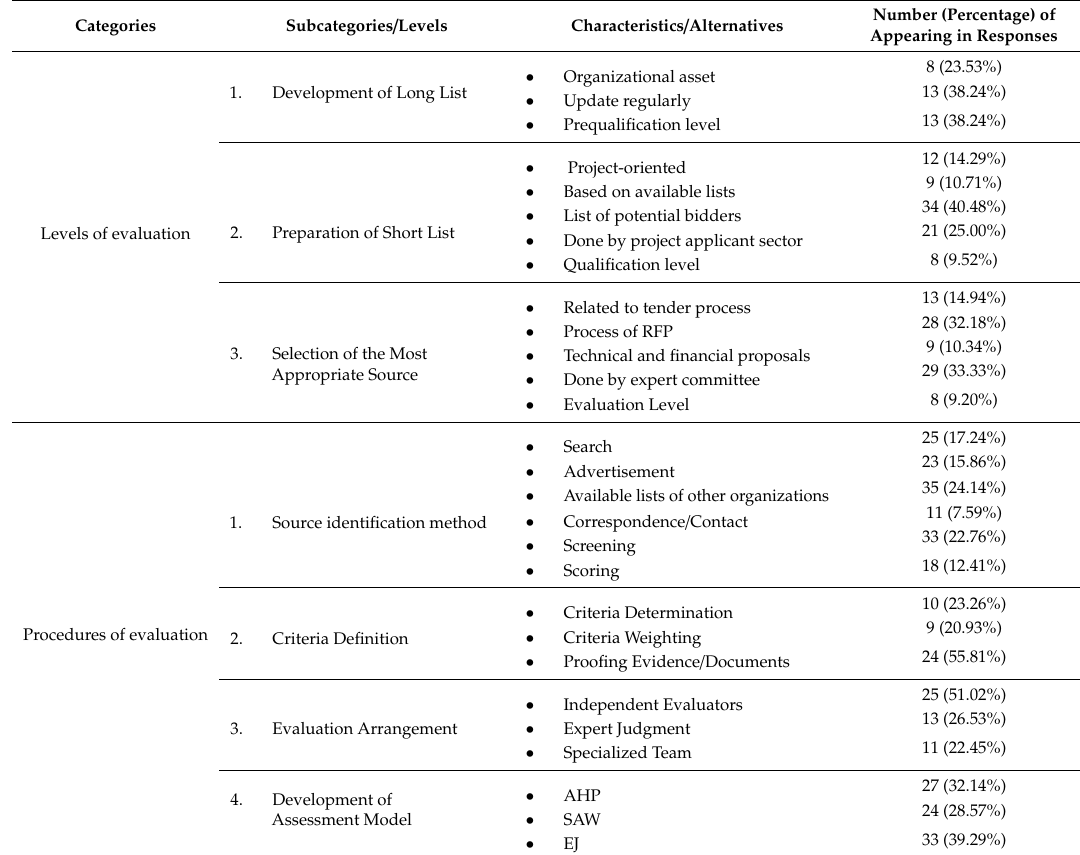
Table 4. Summary of gathered data of received